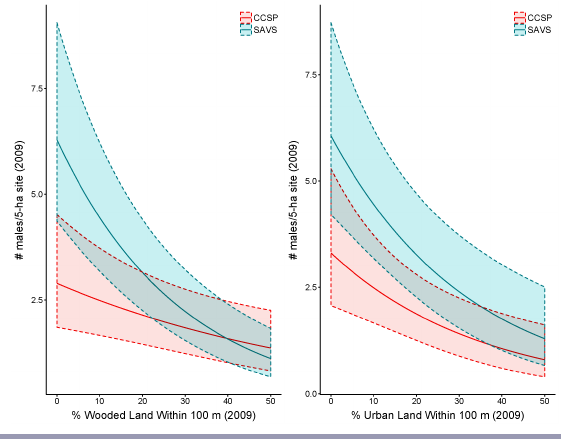
Fig. 4. Predicted relationship for Clay-colored Sparrow (CCSP) and Savannah Sparrow (SAVS) densities based on the percentage of land within 100 m of study sites consisting of wooded lands (trees or shrubs) and urban land in 2009. Relationships to both wooded and urban land were determined by the best-ranked hierarchical distance-sampling model for each species in